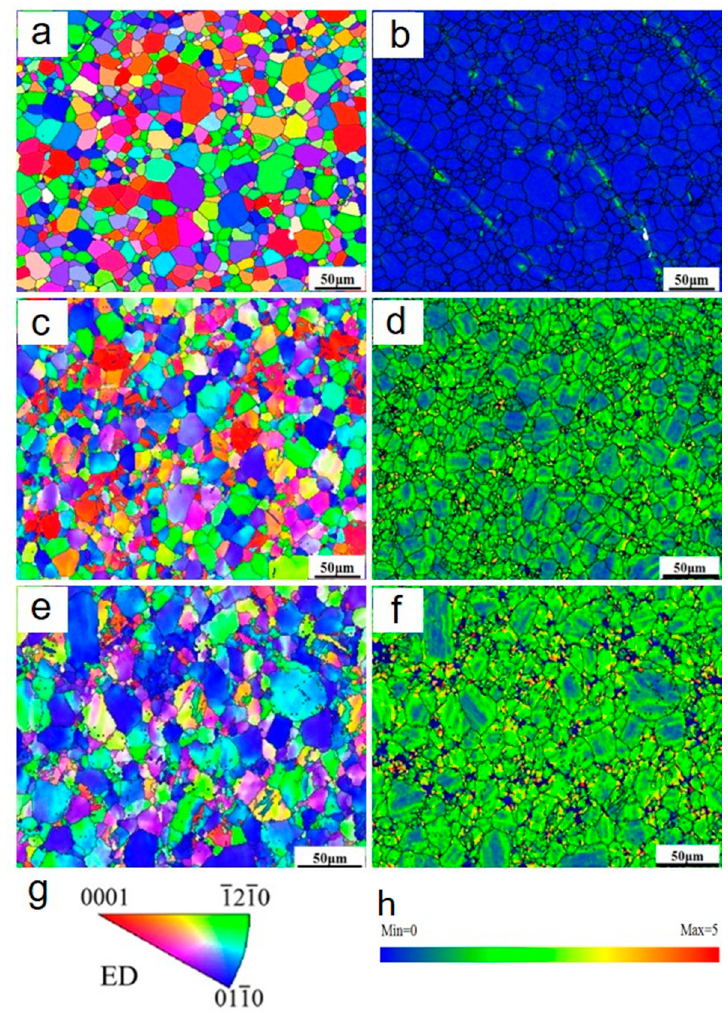
Figure 4. Inverse pole figure maps and local misorientation maps of various samples: ( a , b ) AE; ( c , d ) F-7; ( e , f ) F-12; ( g ) sample orientation; ( h ) local misorientation scale bar.